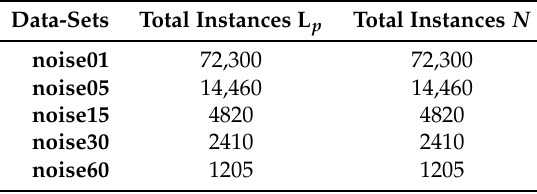
Table 1. Number of samples per data-set for each of the pressure level and loudness